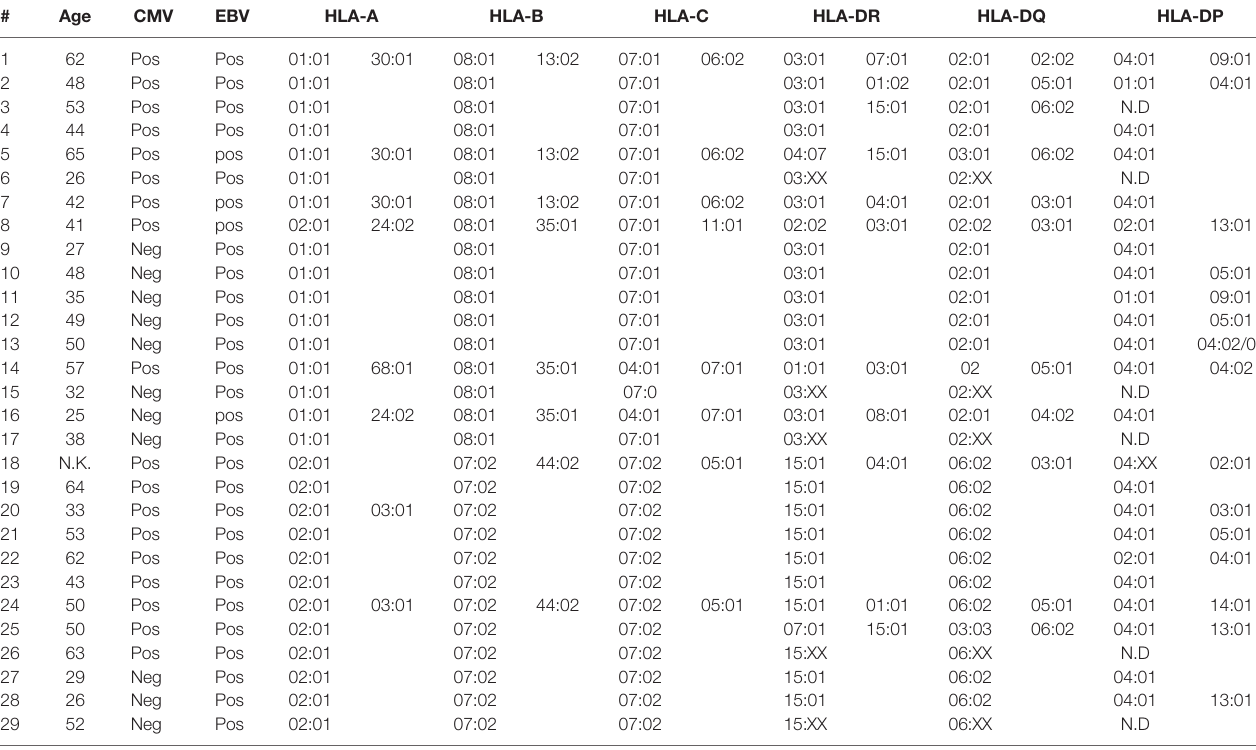
TABLE 1 | HLA typing and CMV/EBV-serostatus of healthy